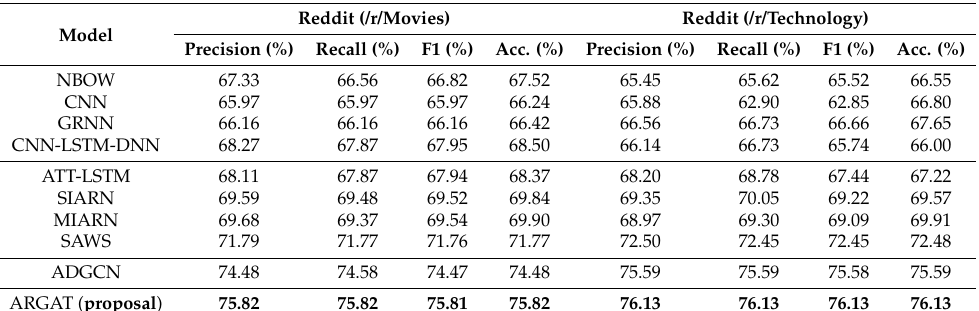
Table 4. Experimental results on Reddit datasets. The best results are in bold and the results of four basic models are from [6].